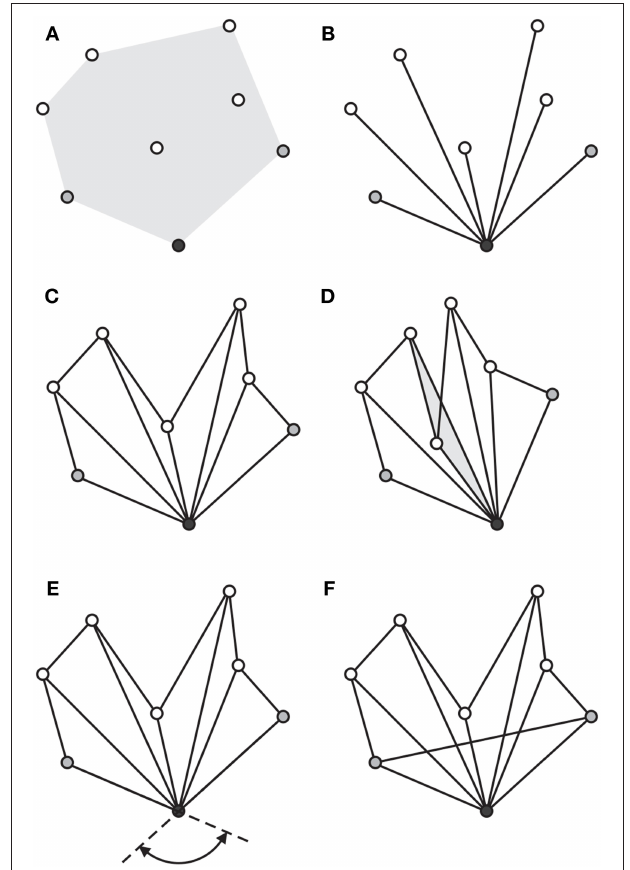
FIGURE 12 | Construction of a nonconvex Grünbaum polygon starting from a set of points in 2D: (A) three nodes corresponding to three consecutive vertices on the boundary of the convex hull of the set, the middle node is the center (in black), the other two nodes are its neighbors (in gray); (B) all the nodes are connected to the center by edges; (C) edges added to form adjacent triangles, so as to obtain a fan ; (D) one of the admissible configurations of this fan, obtained by reversing the triangle shown (in light gray); (E) the completely unfolded configuration of the fan maximize the angle shown; (F) universal rigidity is obtained by adding the last edge between the two neighbors of the